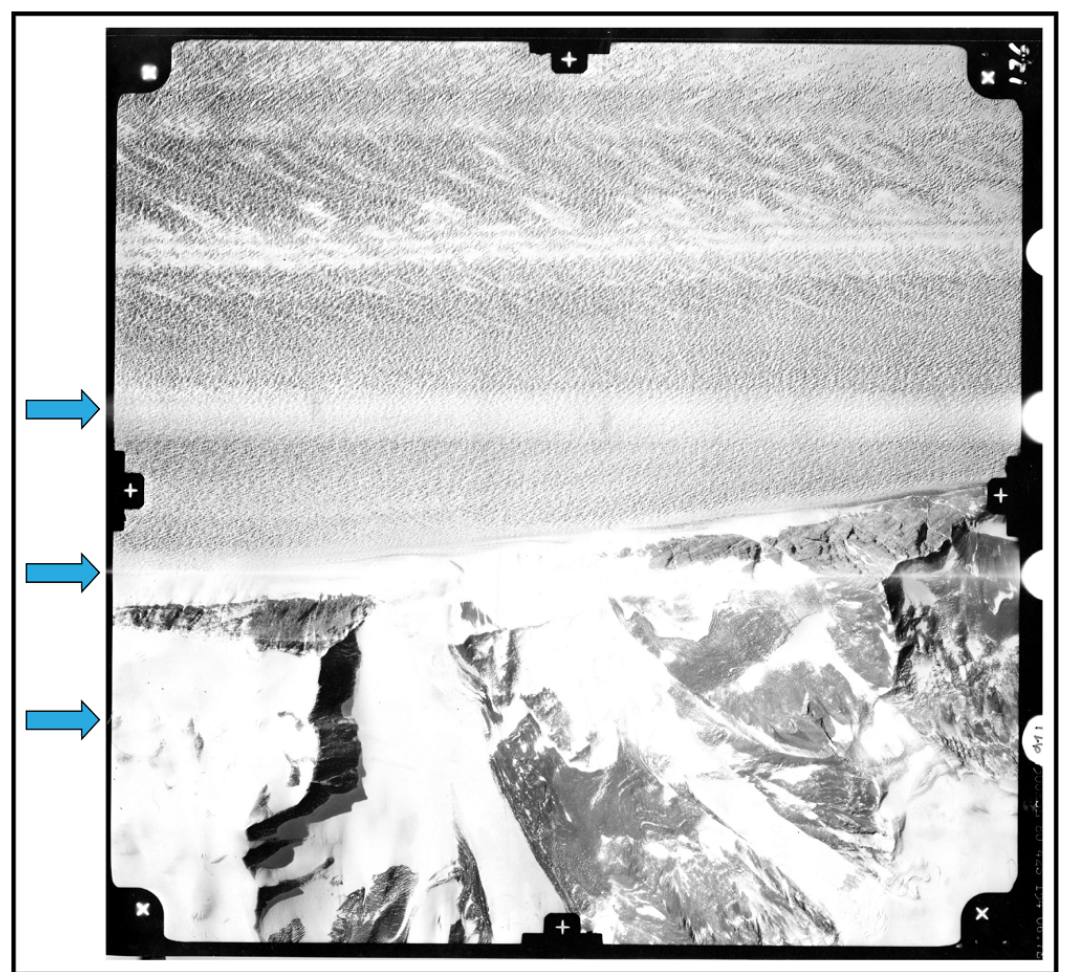
Figure 2. The blue arrows to the left of image CA000400V0126 are highlighting the white stripes caused by a malfunction with the aerial camera’s instrument